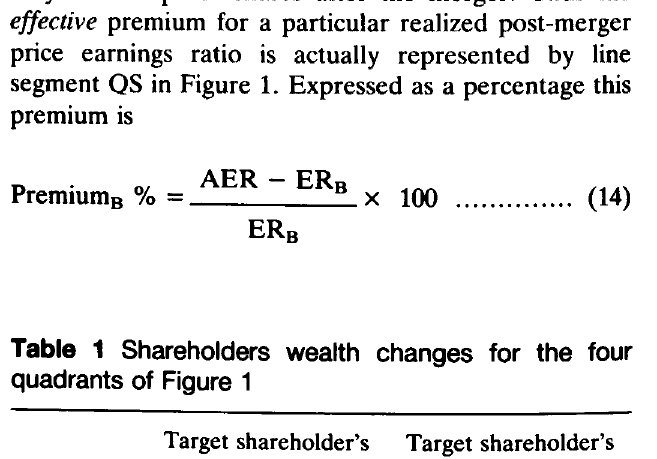
Table 1 Shareholders wealth changes for the four quadrants of Figure